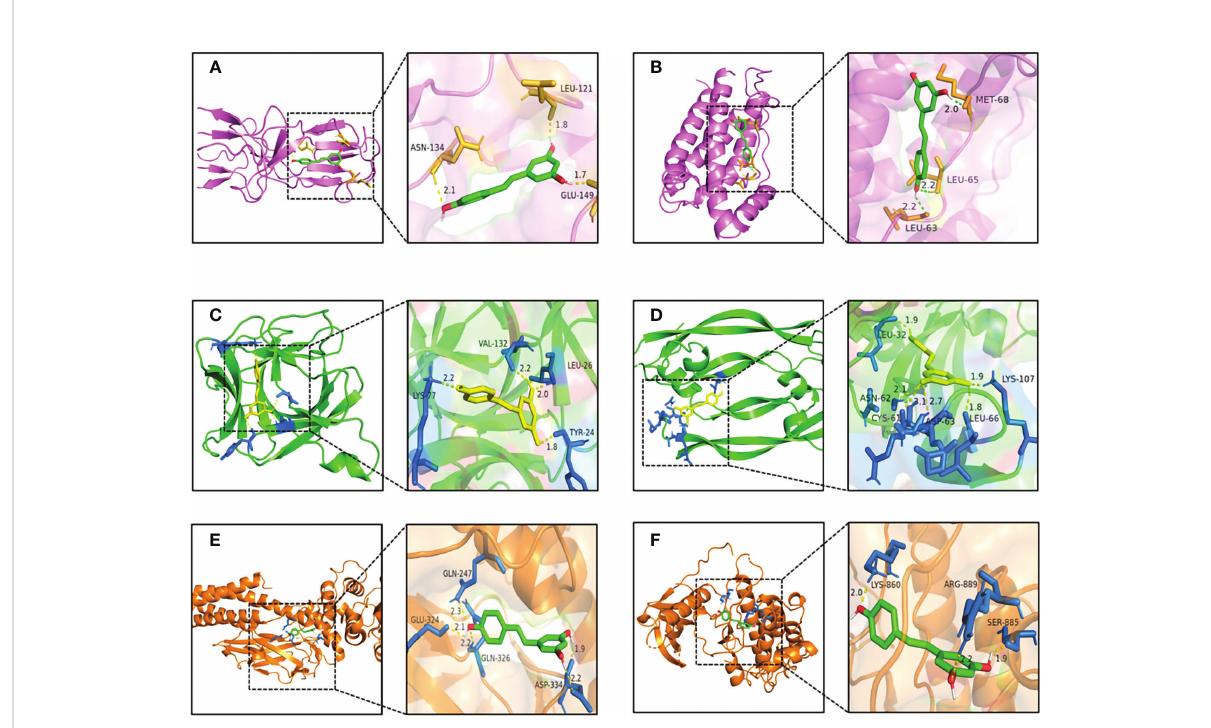
FIGURE 6 The pattern diagrams of molecular docking of RSV and core targets. (A) RSV and TNF, (B) RSV and IL6, (C) RSV and IL1B, (D) RSV and VEGFA, (E) RSV and STAT3, and (F) RSV and EGFR. The decimals mark the length of hydrogen bonds. RSV,